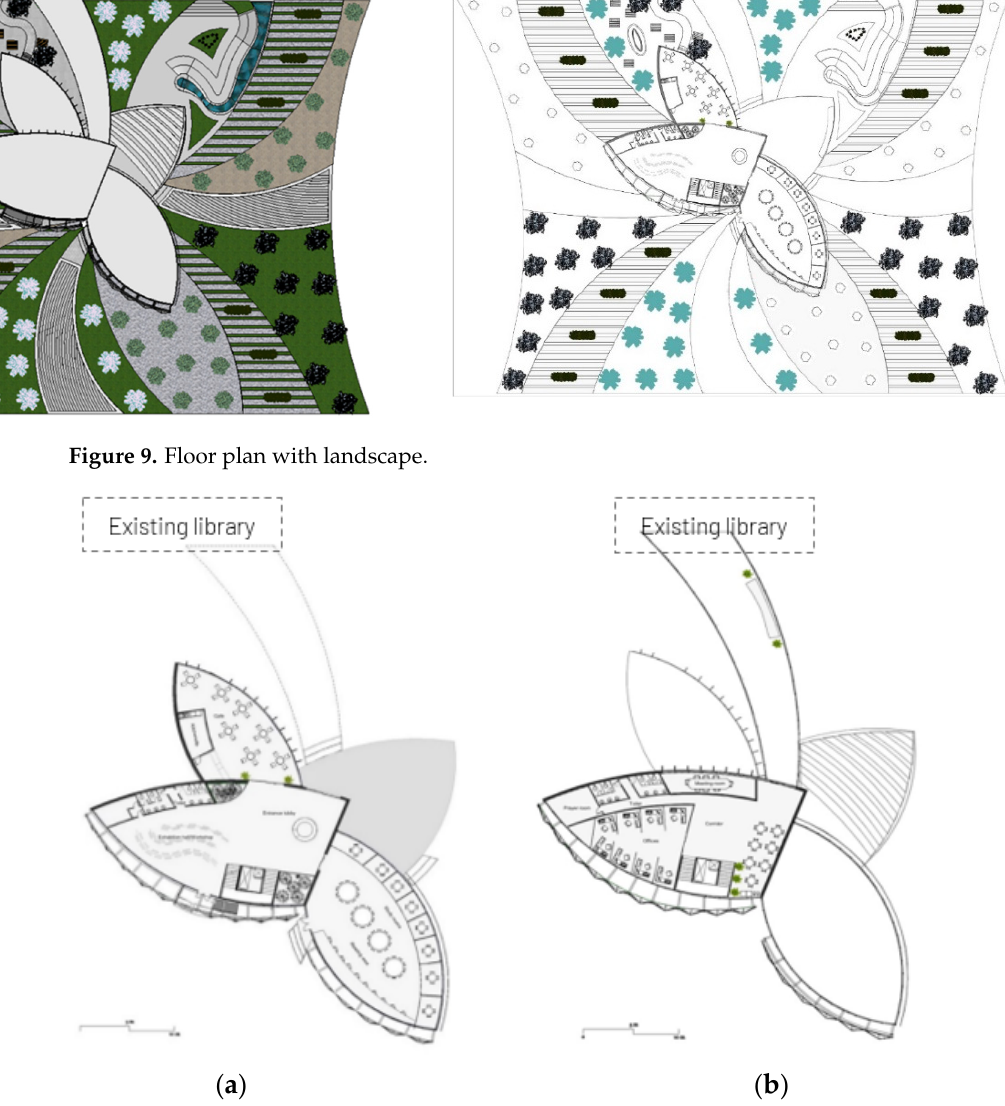
Figure 10. ( a ) Architectural ground floor plan, ( b ) architectural first floor plan.